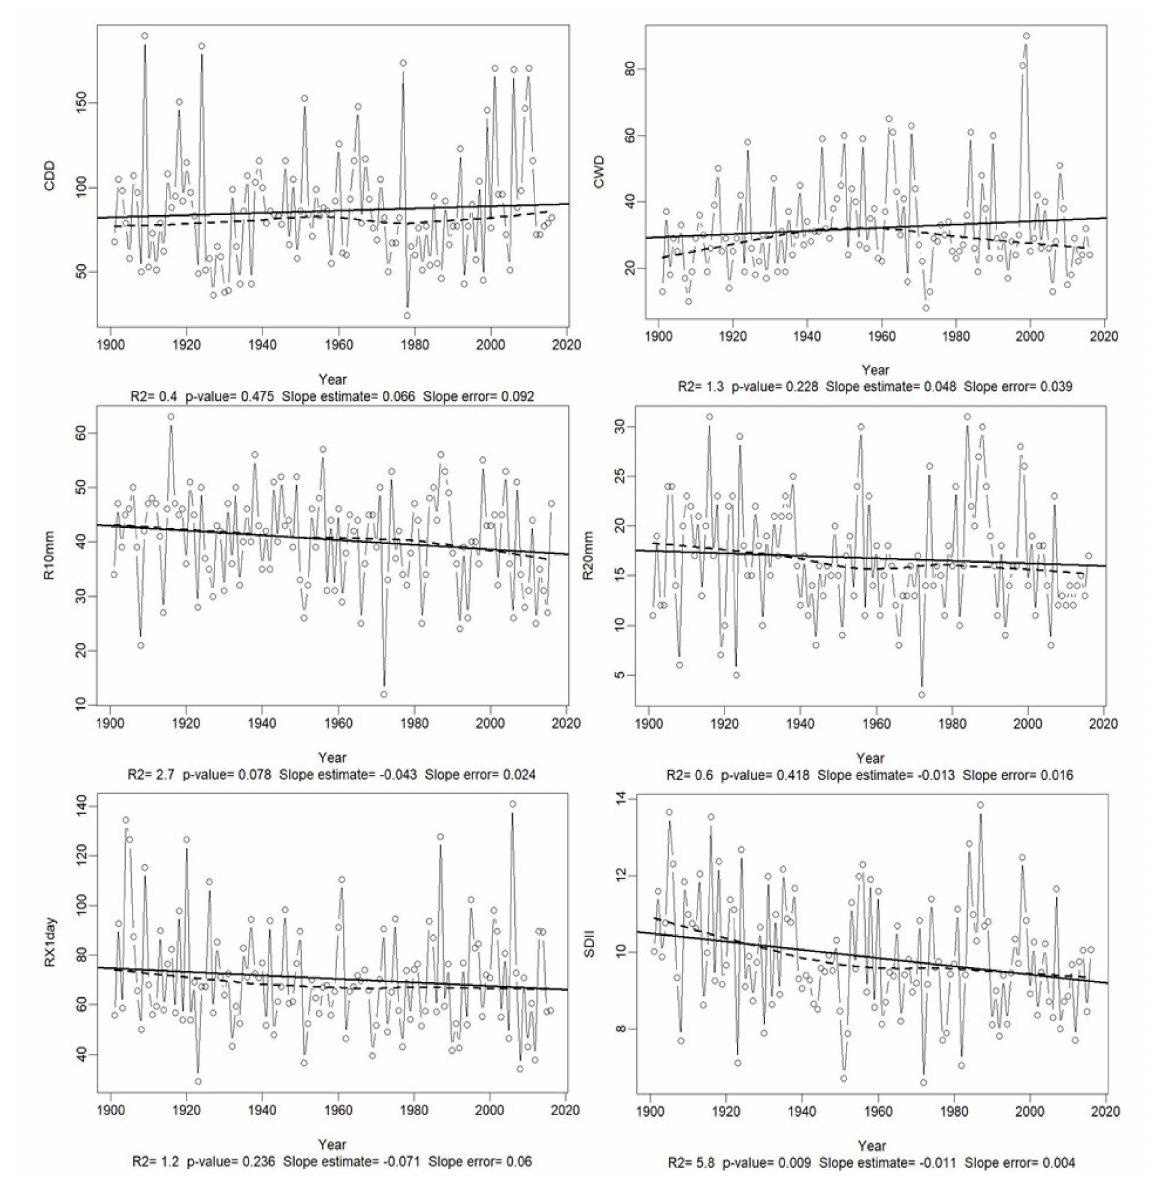
Figure 6. Regionally averaged anomaly of various precipitation extreme indices with line trend (straight line) and best fitting (dotted line) over KRB from 1901 to